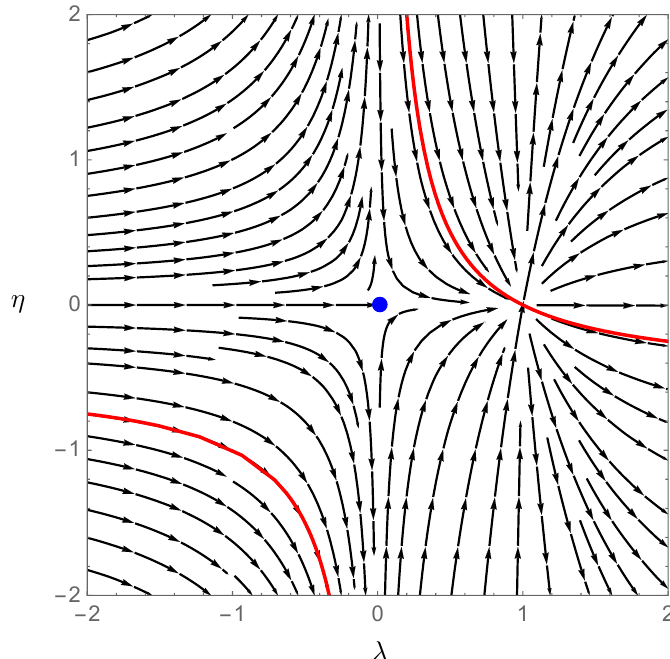
Figure 4 . The RG (cid:13)ow of the YB lambda model ((cid:13)ows towards the IR). The WZW (cid:12)xed point is the blue dot in the middle. The red curved is an example of a cyclic trajectory which has a jump from (cid:17) = + 1 to (cid:0)1 at (cid:21) = 0 and a jump from (cid:21) = (cid:0)1 to (cid:21) = + 1 . The RG (cid:13)ows are shown in (cid:12)gure 4. Apart from discontinuities at in(cid:12)nity, the